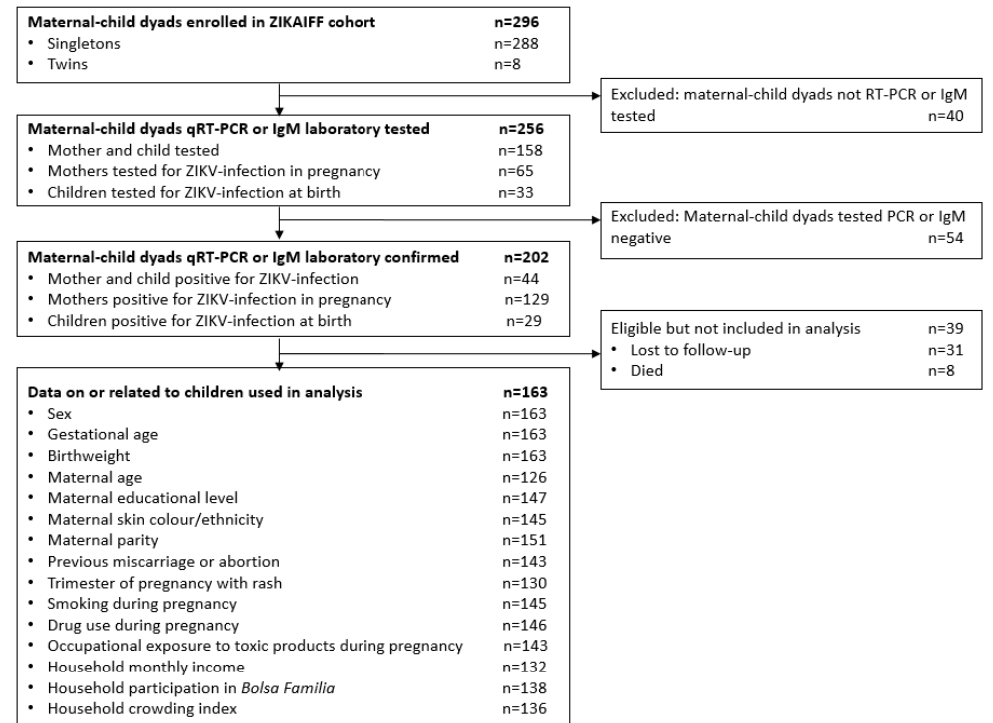
Table 1. Baseline distribution of selected cohort characteristics ( n = 163).